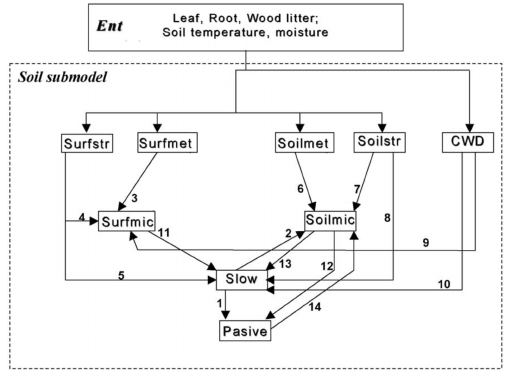
Figure B1. Schematic diagram of the soil biogeochemistry sub- model of Ent (showing nine soil C pools only; modified from Potter et al., 1993). Surfstr – surface structural pool; Surfmet – surface metabolic pool; Soilmet − soil metabolic pool (fastest to decom- pose; 20-day turnover time); Soilstr – soil structural pool; Surfmic – surface microbial pool; Soilmic – soil microbial pool; Slow – slowly decomposing pool; Passive – very slowly decomposing pool (500- year turnover time). All pools except for the three surf ∗∗∗ pools are assumed to be present in the two lower soil layers in addition to the top layer.